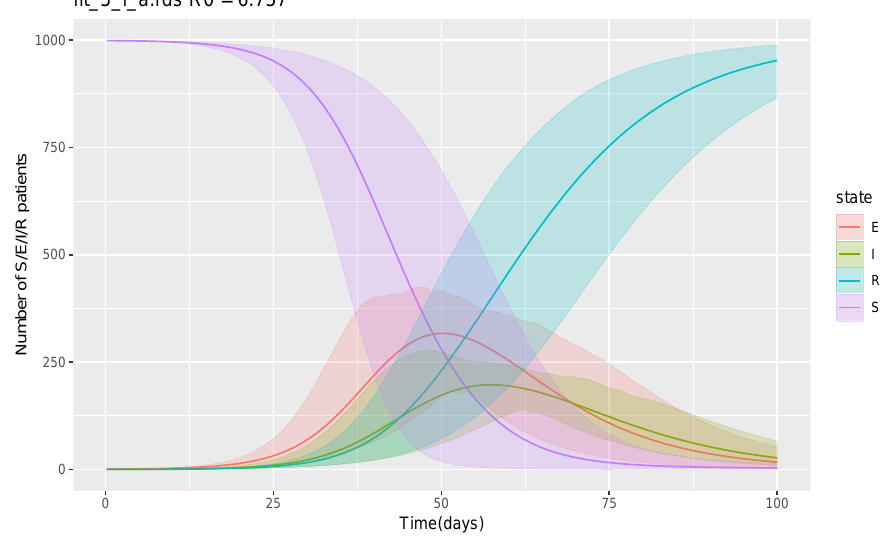
Figure 1. SEIR model with the worst case scenario. Abbreviations S = susceptible E = exposed, I = infected, and R = recovered and removed.